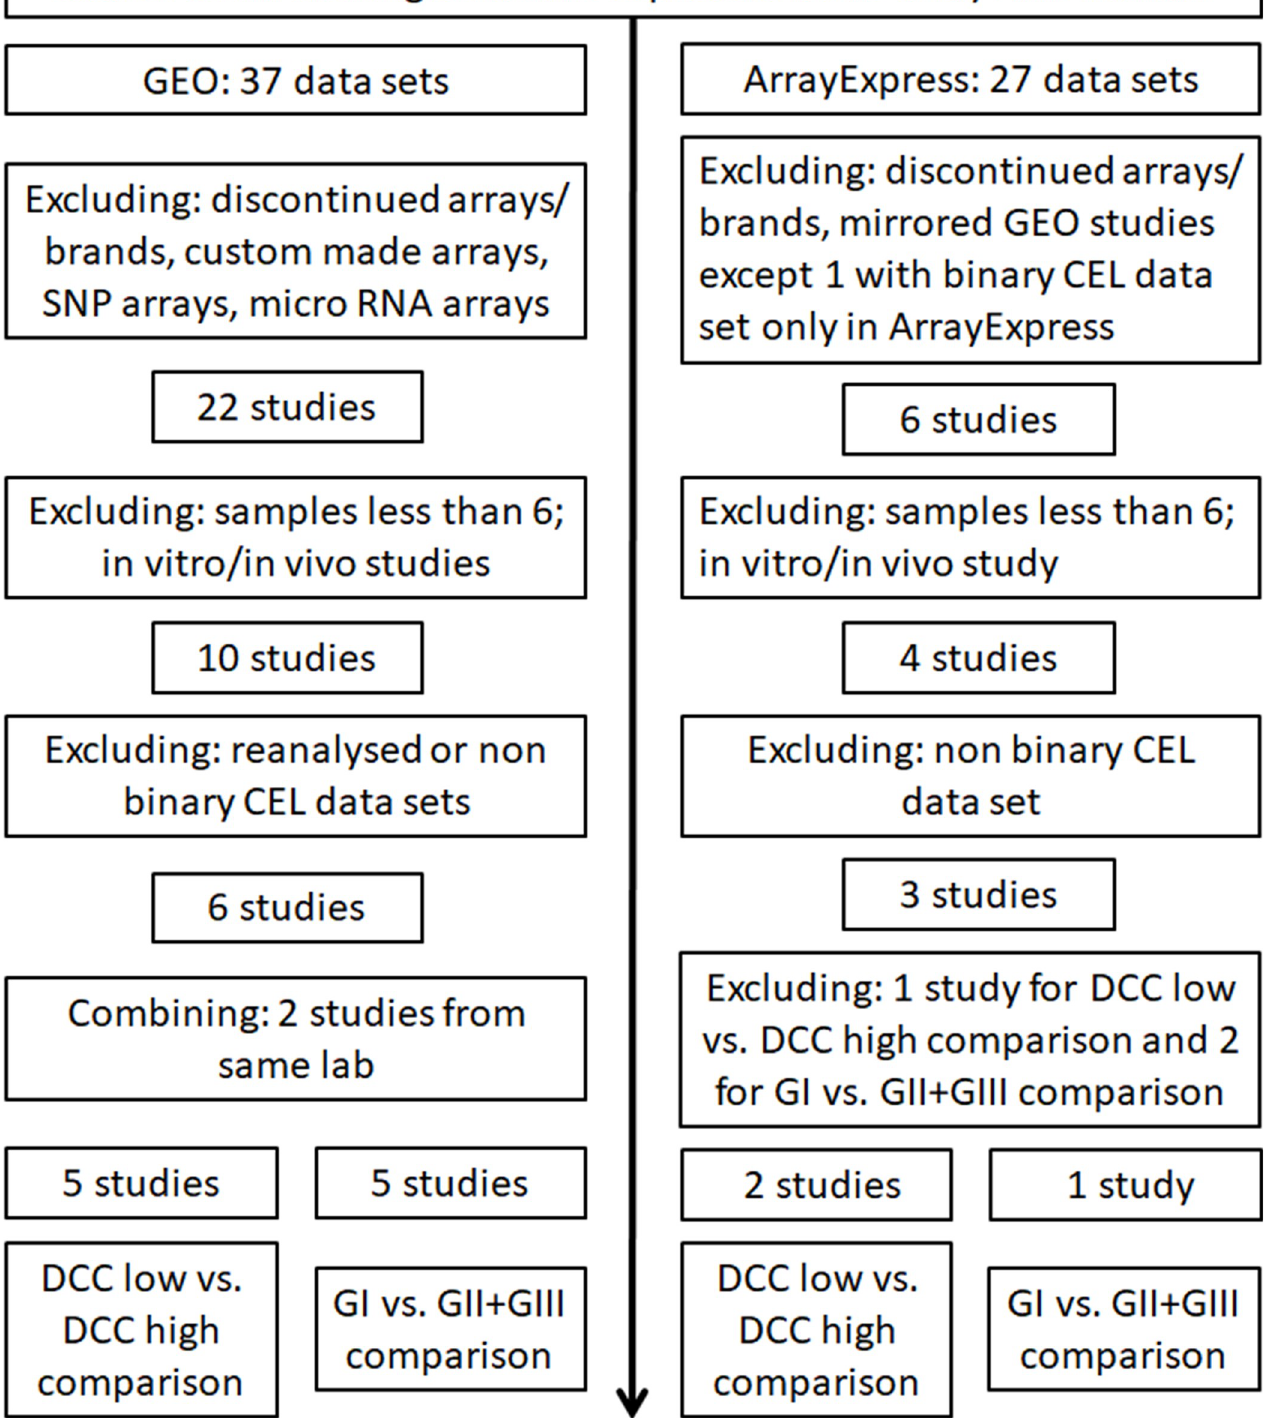
Fig 1. Flow chart for selecting CSC genes from meningioma array studies. Two publicly accessible array expression repositories were assessed to retrieve up- to-date array expression data sets on meningiomas.